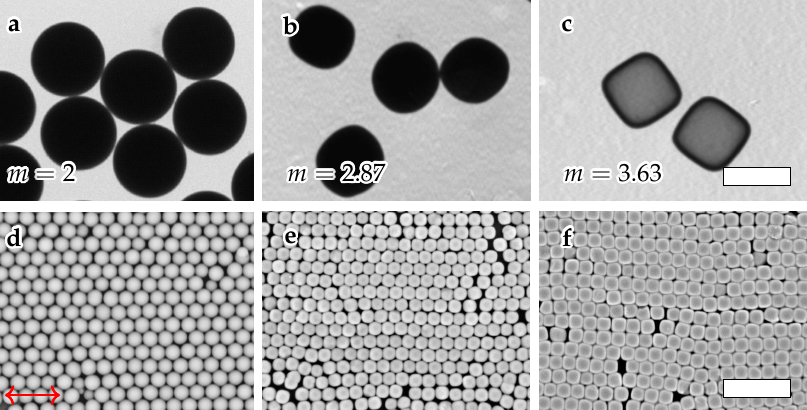
Figure 1. Representative ( a – c ) transmission electron microscopy (TEM) images of the colloidal superballs and ( d – f ) scanning electron microscopy (SEM) images of their corresponding monolayers assembled using the unidirectional rubbing method. The direction of the mechanical rubbing is indicated in the images using a red arrow. The scale bars represent ( a – c ) 1 and ( d – f )